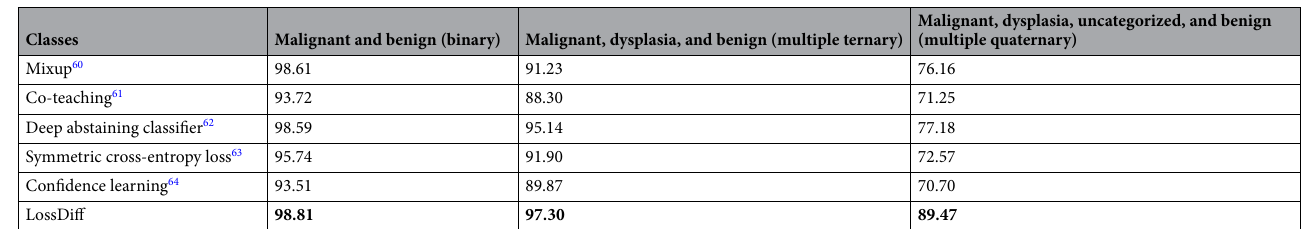
Table 9. Accuracy comparisons between extant label noising methods and LossDiff using the same set of stomach image data. Significant values are in